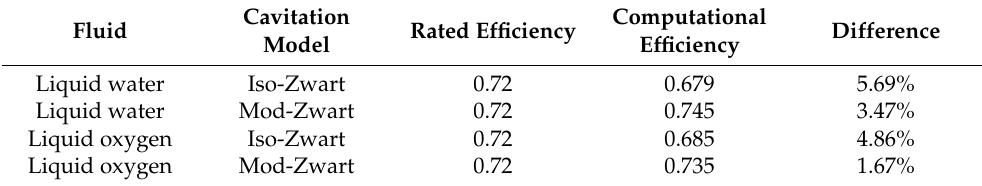
Table 4. Comparison of the cavitation efficiency of liquid water and liquid oxygen in different models.